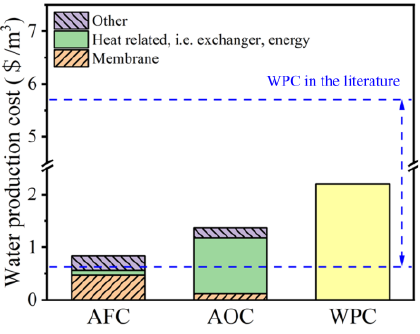
Figure 6. The annual fixed cost (AFC), annual operating cost (AOC), and total water production cost (WPC, sum of the AFC and AOC) estimated for the shale gas wastewater treatment using the PVDF-CNT-FAS membrane in this study, including a section for the membrane, heat exchange or thermal energy, and other expenses. The cost analysis for the PVDF membrane is not provided considering its deteriorated permeate quality compared with the local standard.